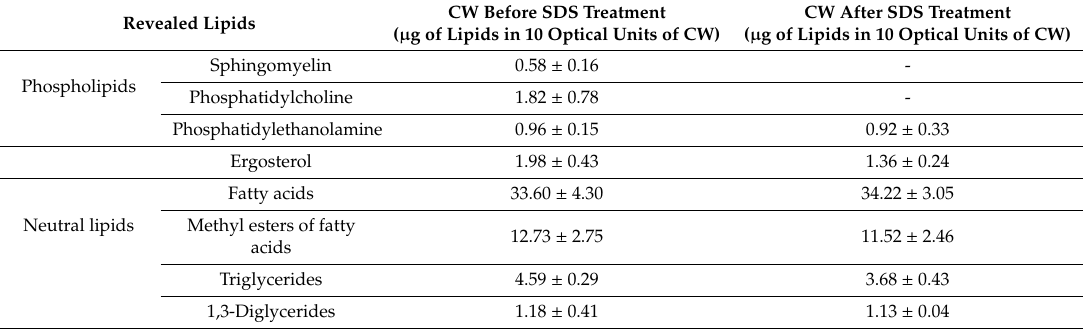
Table 2. Quantification of lipid component in Saccharomyces cerevisiae cell walls before and after SDS treatment